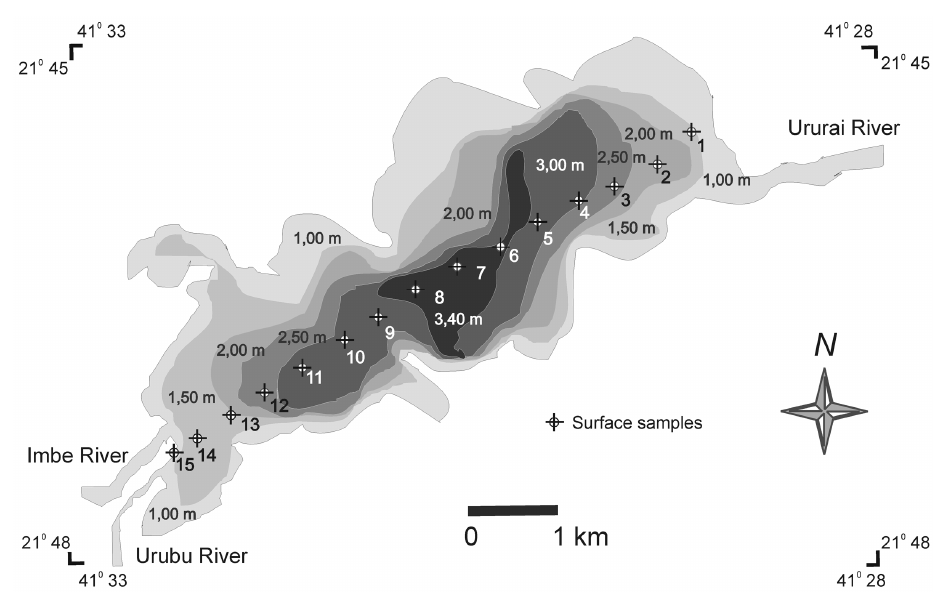
Fig. 2 – Bathymetric map of the Lagoa de Cima Lake with the localization of the surface sediment samples.